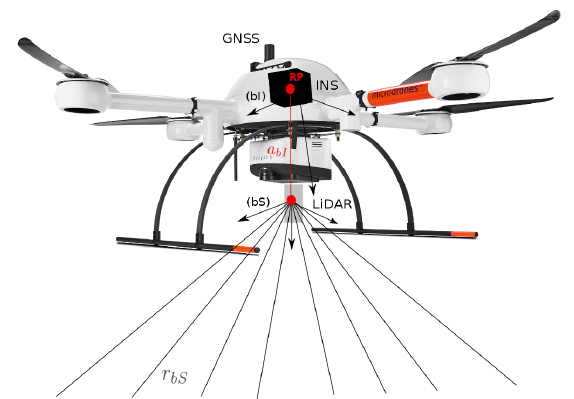
Figure 1. Geometry of a mobile LiDAR system. The positioning system is supposed to compute the position of the PRP, denoted by RP. The lever-arm is denoted by (cid:126)a , ( bS = ( X bS , Y bS , Z bS )) is the LiDAR body frame, and ( bI = ( X bI , Y bI , Z bI )) is the IMU/INS body